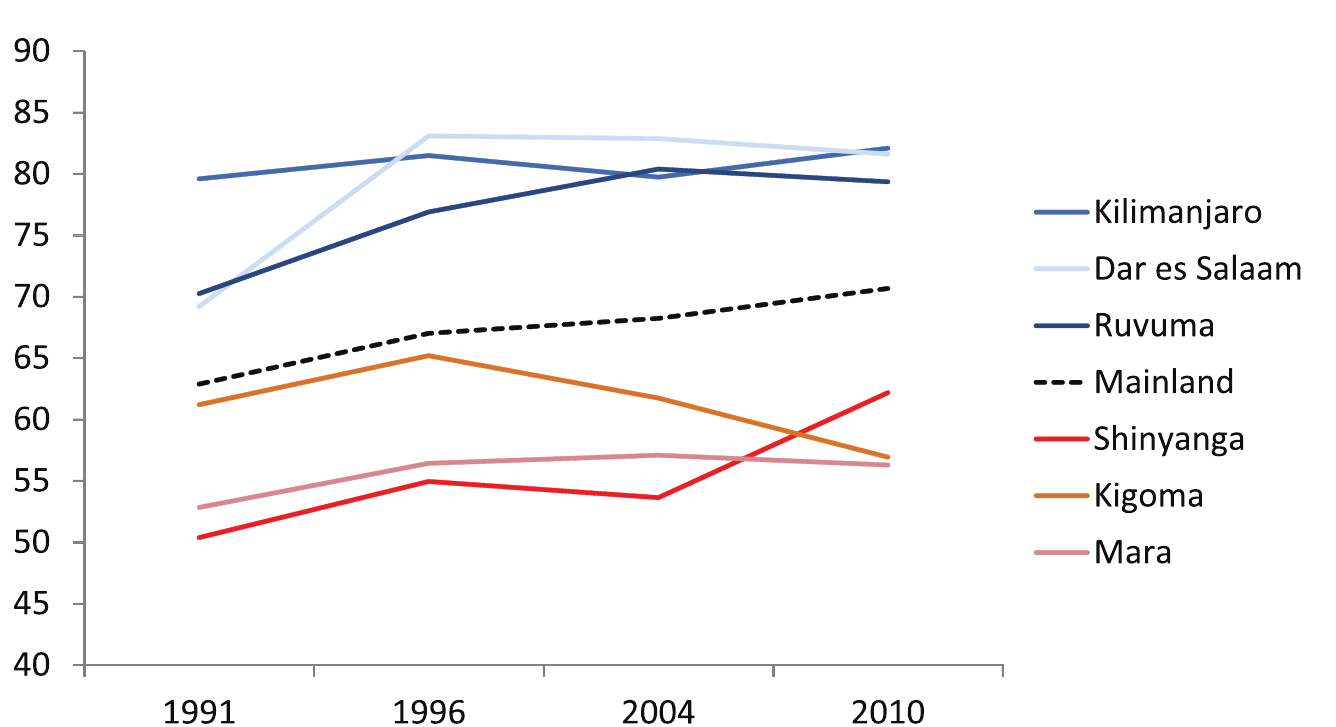
Fig 5. Inequalities in the Countdown MNCH coverage score (see text), based on survey data 1991 – 2010, national trend with three best and three poorest regions according to the 2010 survey.